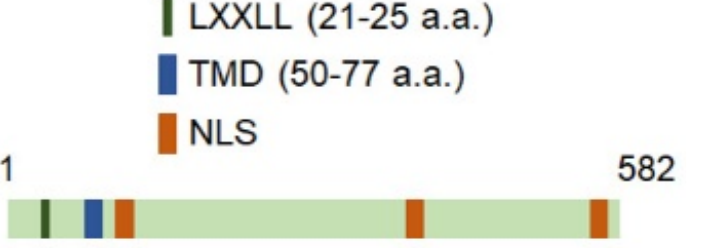
Figure 1. Cartoon showing AEG-1 protein not shown to scale. Human AEG-1 protein contains 582 amino acids (a.a.). TMD: Transmembrane domain facilitating anchoring in ER or cell membrane. NLS: Nuclear localization signal facilitating translocation of AEG-1 to the nucleus. LXXLL motif allows AEG-1 to interact with RXR and inhibit RXR function.